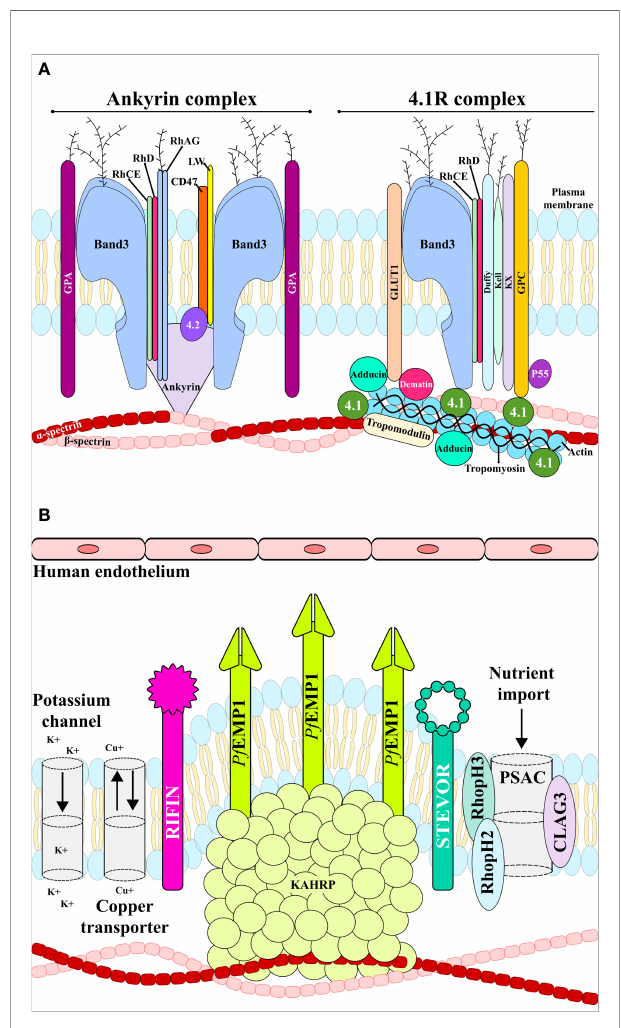
FIGURE 3 | RBC membrane. (A) uninfected RBC membrane with the ankyrin and 4.1R complexes linking the bilayer with the membrane skeleton. (B) Infected RBC membrane with anion channels, the exported parasite proteins Pf EMP1, STEVOR and RIFIN, and the expressed adhesin KAHRP. These proteins interact with host receptors mediating cytoadherence to the human endothelial